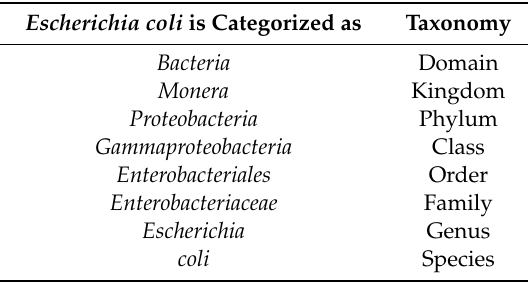
Table 1. Taxonomic categories of